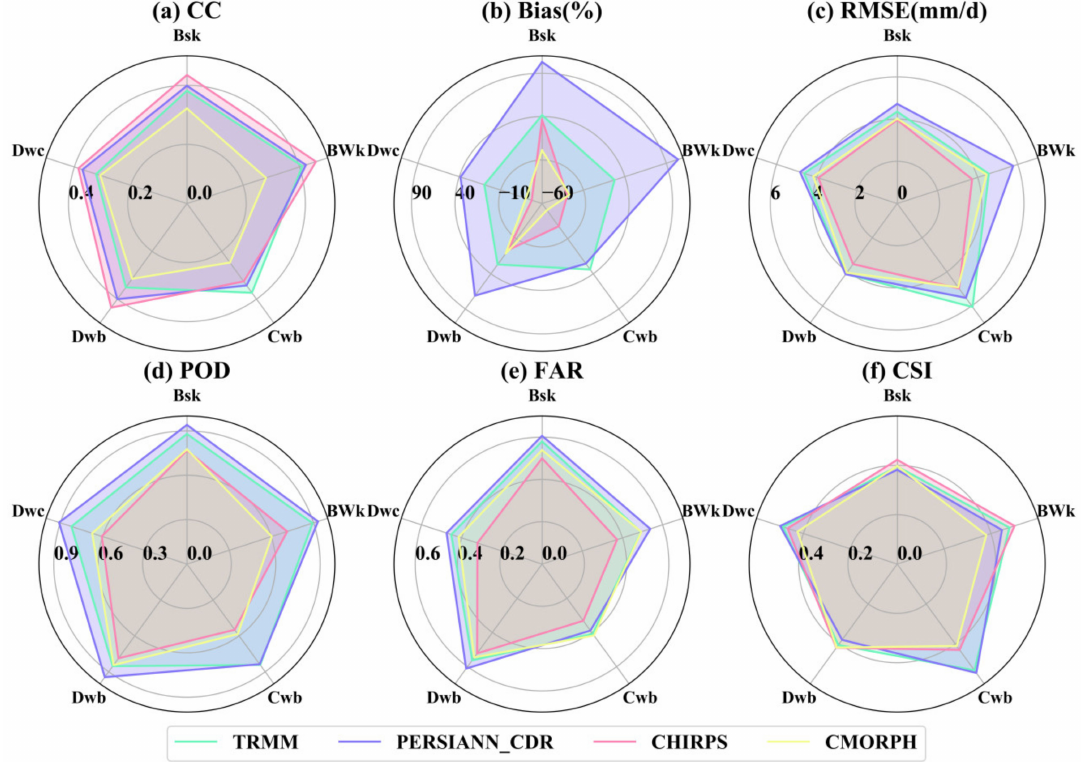
Figure 12. Radar map for the daily precipitation metrics of all gauges and corresponding product grids over different climatic zones: ( a – f ) CC, Bias, RMSE, POD, FAR, and CSI, respectively. The label abbreviations are explained below. Bsk: Cold semi-arid climate; BWk: Cold desert climate; Cwb: Subtropical highland climate; Dwb: Monsoon-influenced warm-summer humid continental